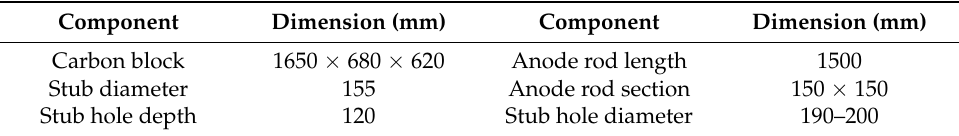
Table 1. Main dimensions of the model.